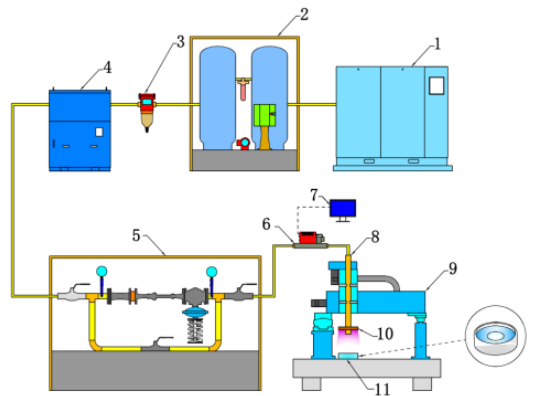
Figure 11. Setup of the experimental the gas jet forming platform: (1) air compressor; (2) coupled gas tank; (3) water–oil separator; (4) refrigeration dryer; (5) gas MFC; (6) gas jet controller; (7) upper computer; (8) precision electroplated nozzle; (9) precision three-axis moving platform; (10) UV light source; (11) marble platform.